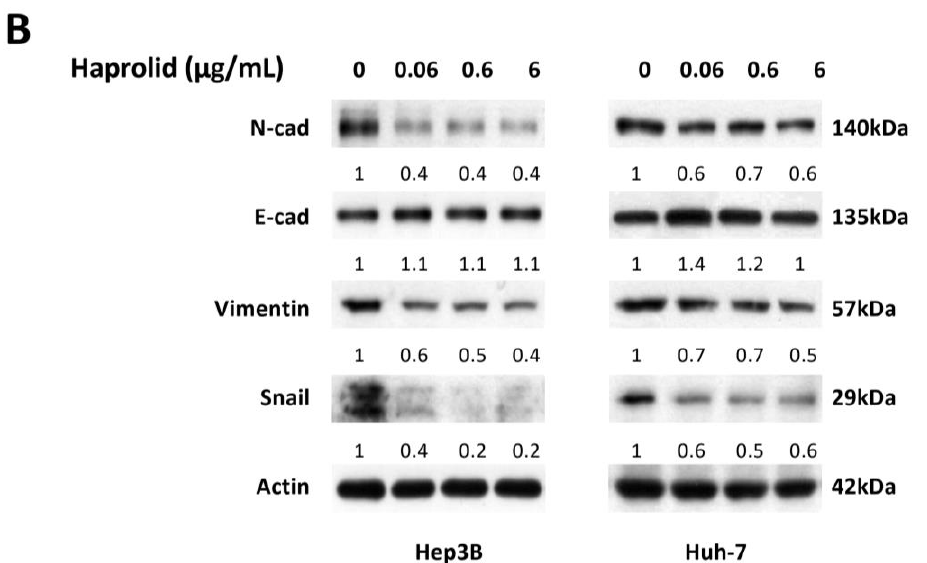
Figure 3. Haprolid treatment inhibits tumor spheroids growth and invasion and partially impairs epithelial–mesenchymal transition (EMT) in human HCC cells. ( A ) Three-dimensional tumor spheroid assay was performed to evaluate effects of haprolid on HCC cell proliferative and invasive ability in extracellular-matrix-like environment. The representative images of spheroids are shown. The changes of spheroids size were monitored and quantified up to 10 days and plotted in bar graphs. ( B ) Hep3B and Huh-7 cells were treated with DMSO or haprolid (0.06, 0.6 and 6 µg/mL) for 96 h. The expressions of EMT markers (N-cadherin, E-cadherin, vimentin and Snail) were analyzed by immunoblotting. Western blotting bands were quantified by Image J and normalized to their respective β-actin then compared with vehicle-treated controls. Data represent means ± SEM of at least three independent experiments. * p < 0.05, ** p < 0.01, *** p < 0.001, **** p < 0.0001.